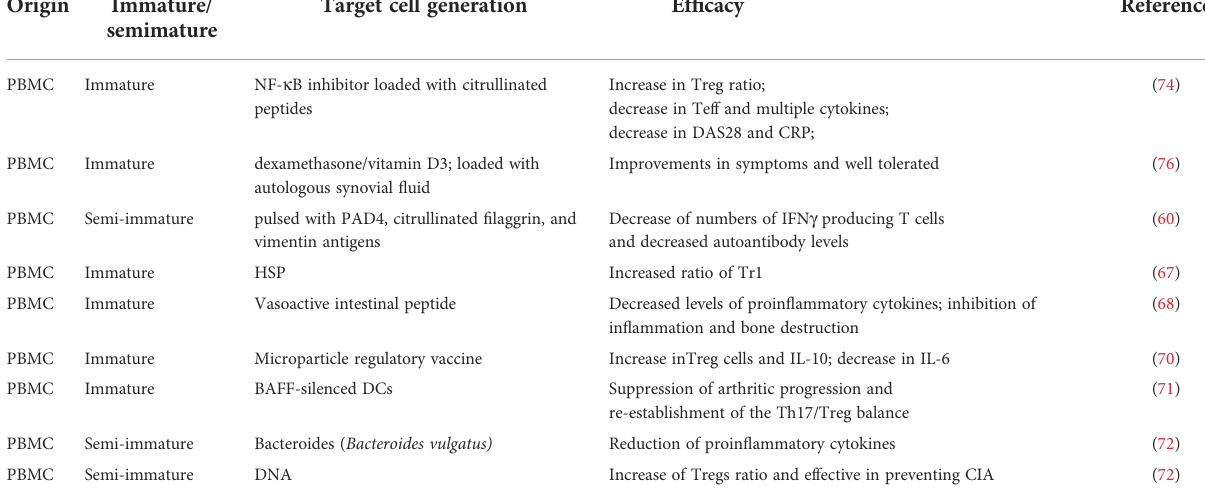
TABLE 3 Animal and Clinical Trials involving tolDCs in RA